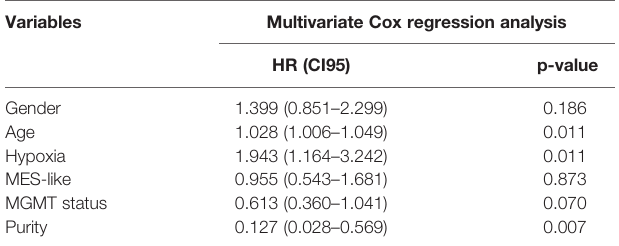
TABLE 1 | Statistic of prognostic related factors in TCGA